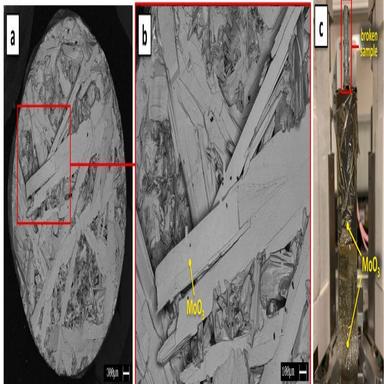
(a) SEM image of specimen fracture surface, tested at 800 ◦C in TEC-Eurolab; (b) on oxidized surface with MoO3 crystal; (c) image of set-up after static test at 800 ◦C showing extended MoO3 crystallization on clamps and chamber.